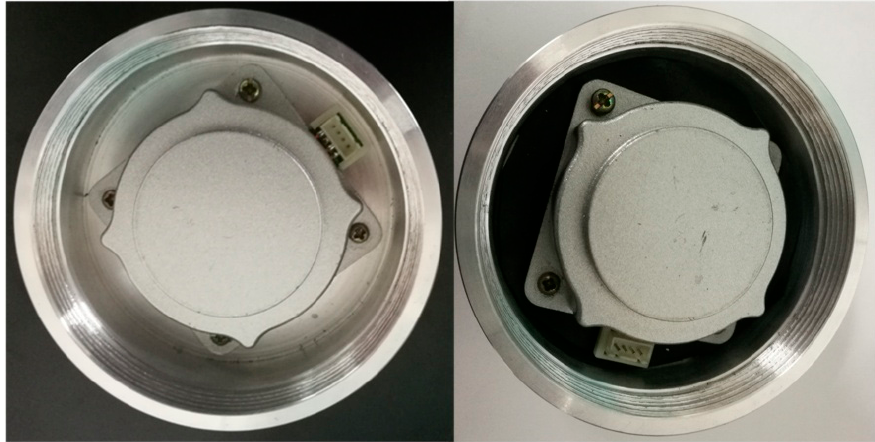
Figure 13. Ultrasonic motor with (right) and without (left) the protection of rubber.